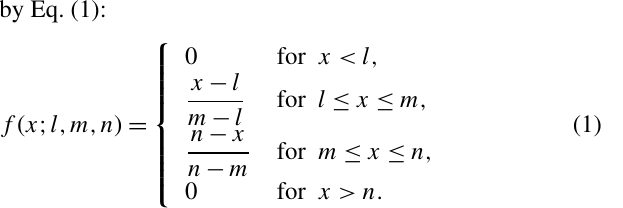
Table 1. Groups defined for water quality